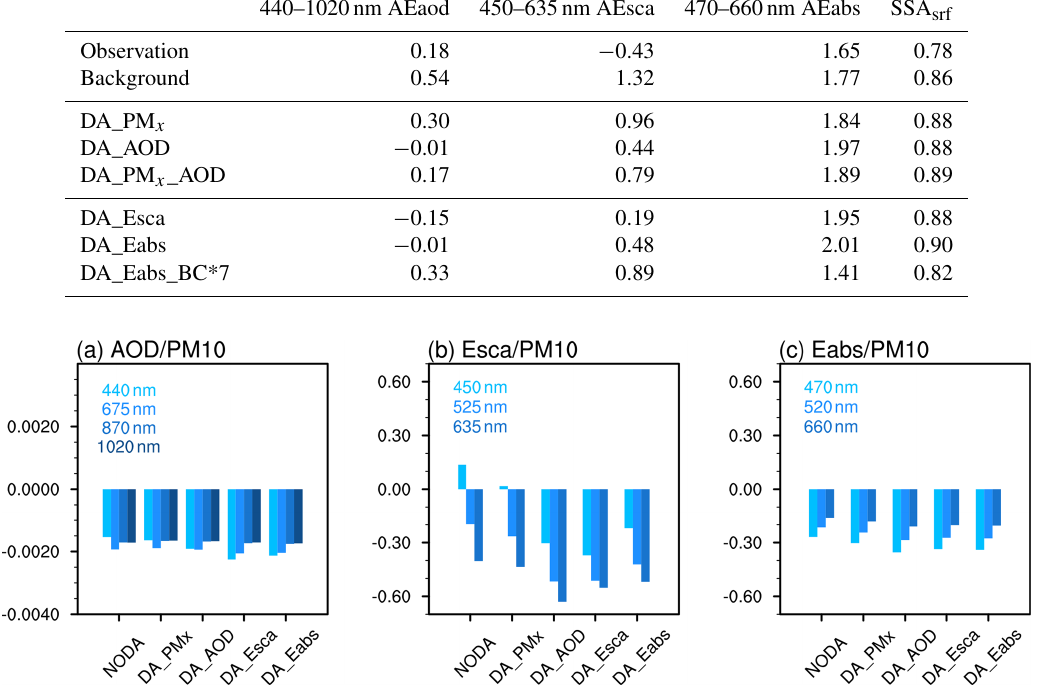
Figure 10. Mean biases in the ratio of AOD to PM 10 , the mass scattering efficiency (Esca / PM 10 ,Mm − 1 µg − 1 m 3 ), and the mass absorbing efficiency (Eabs / PM 10 ,Mm − 1 µg − 1 m 3 ) at Kashi in April